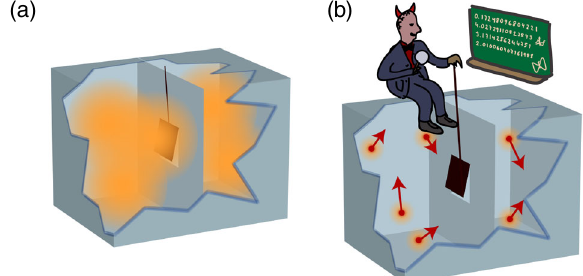
FIG. 3. The Maxwell demon concentrates all particles on one side of the box by opening the trap door at appropriate times. (a) A macroscopic observer describing only the gas sees its entropy decrease, in apparent violation of the macroscopic observer ’ s idea of the second law of thermodynamics. (b) The demon observes no entropy change, as the state of the gas is conditioned on his knowledge. By modeling his memory as an explicit system, originally in a pure state, we may understand his actions as simply correlating his memory with the state of the gas.